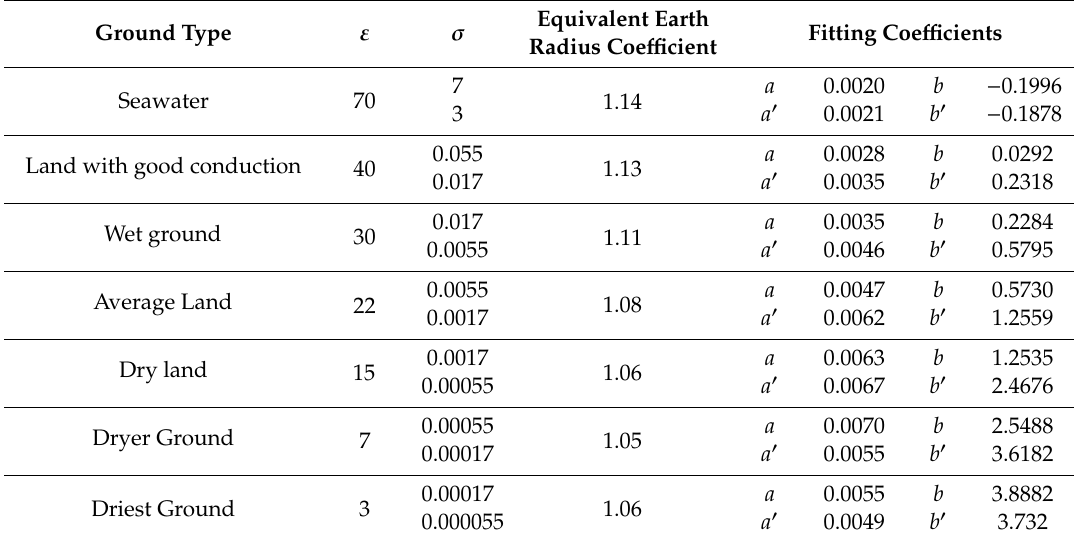
Table 3. Additional secondary factor (ASF) fitting coe ffi cient of the typical path.